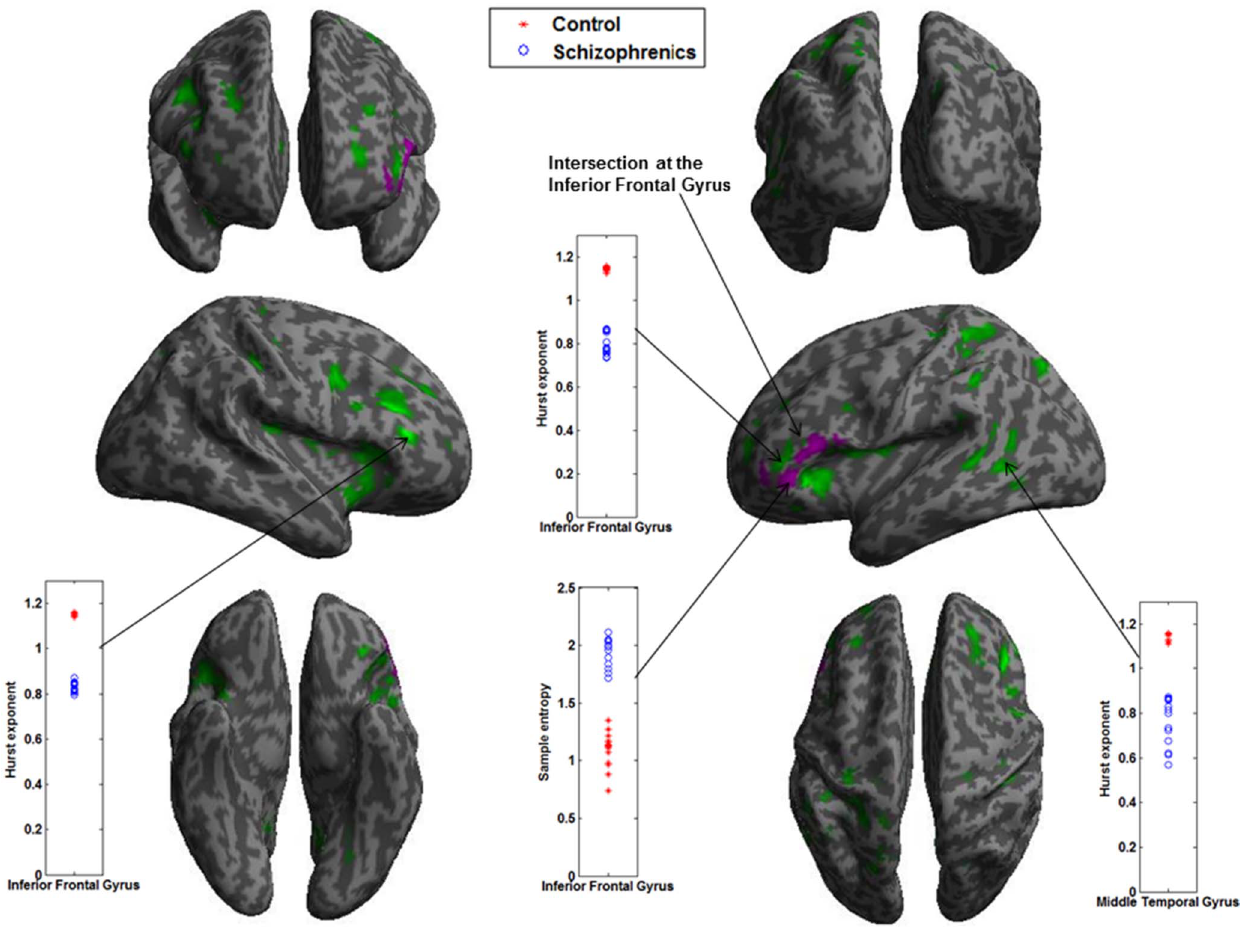
Figure 5. Scatter plots and rendered images showing differences between control and patients with schizophrenia after correcting for age and sex differences together. Scatter plots depict the mean SampEn and H values at different brain ROI. Rendered images show the difference in SampEn and H between the control and patients with schizophrenia. Regions shown have higher complexity in patients with schizophrenia. See table 2 for a complete list of these regions (threshold p=0.005 and corrected cluster p , 0.05).